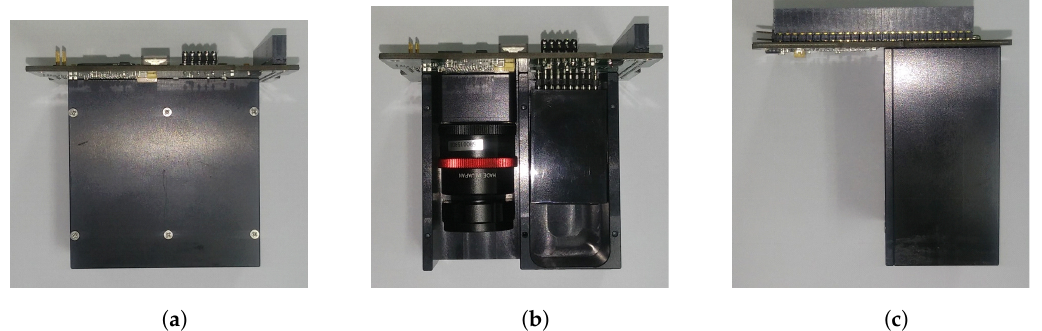
Figure 6. Design of lens housing for TLE observation system. ( a ) Side view with cover; ( b ) Side view without cover; ( c ) Front view with